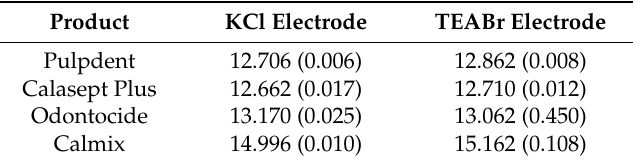
Table 3. pH assessments using conventional and non-aqueous